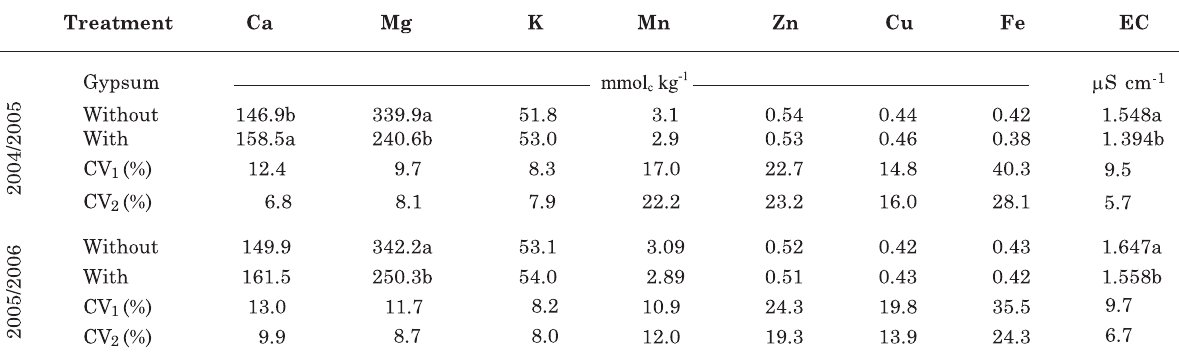
Table 2. Contents of water-soluble nutrients and electrical conductivity (EC) in the plant extracts of flowering peanut as related to the surface application or non-application of gypsum in 2004/2005 and